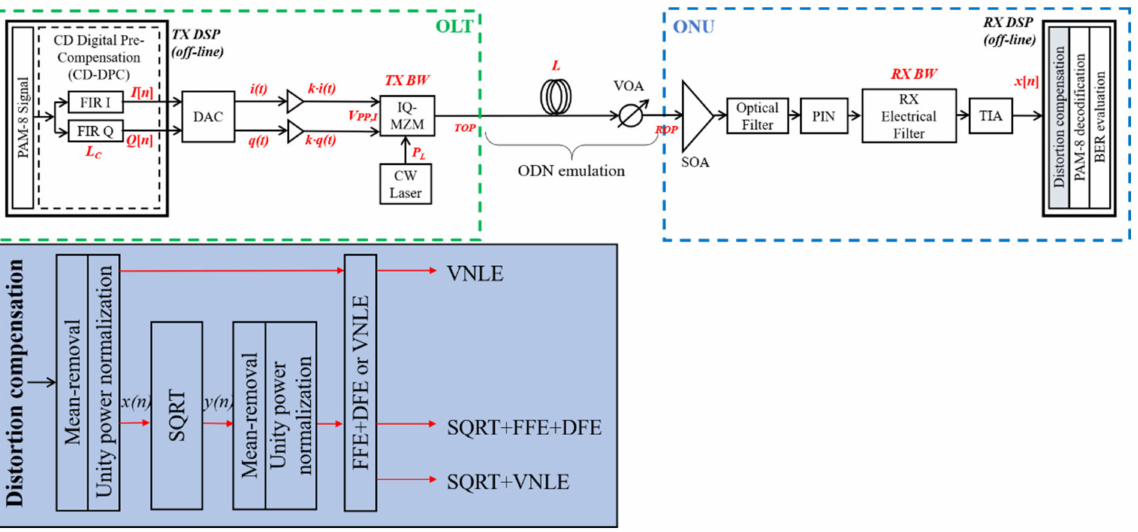
Figure 1. Simulation setup of the proposed CD-DPC DD link, emulating a PON downstream transmission. Dispersion compensation blocks with different DSP options are